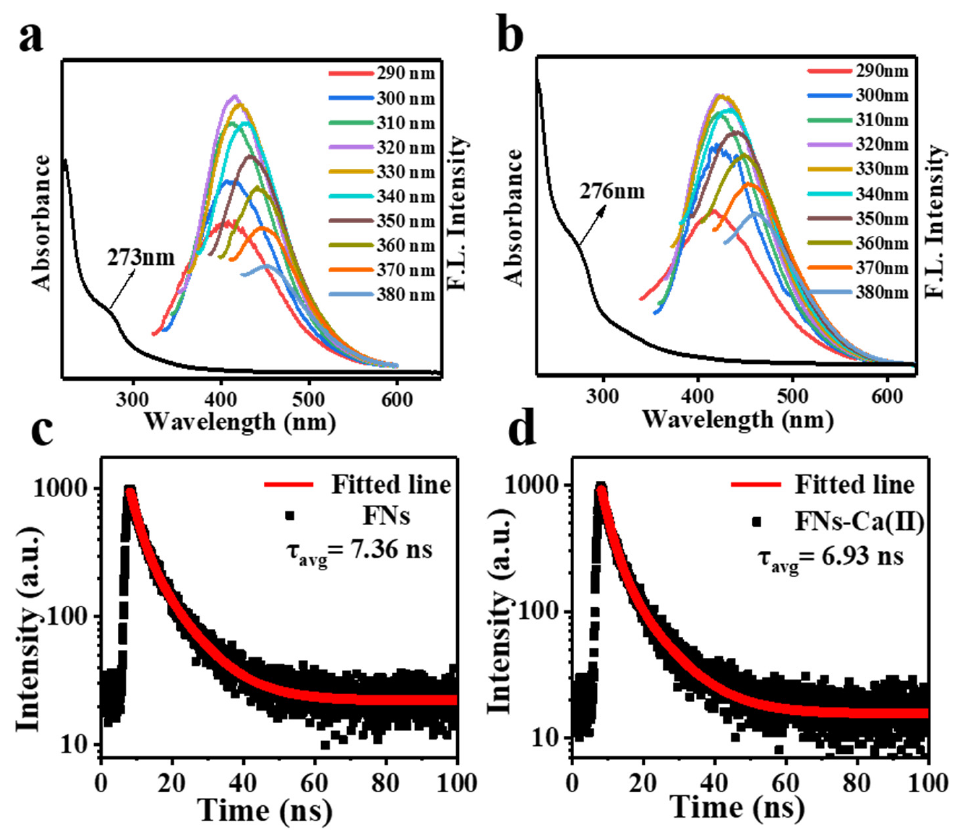
Figure 2. Fluorescence emission spectra and UV − Vis absorption spectra of FNs ( a ) and FNs − Ca(II) ( b ). Time − resolved fluorescence decay curve of FNs ( c ) and FNs − Ca(II) ( d ).